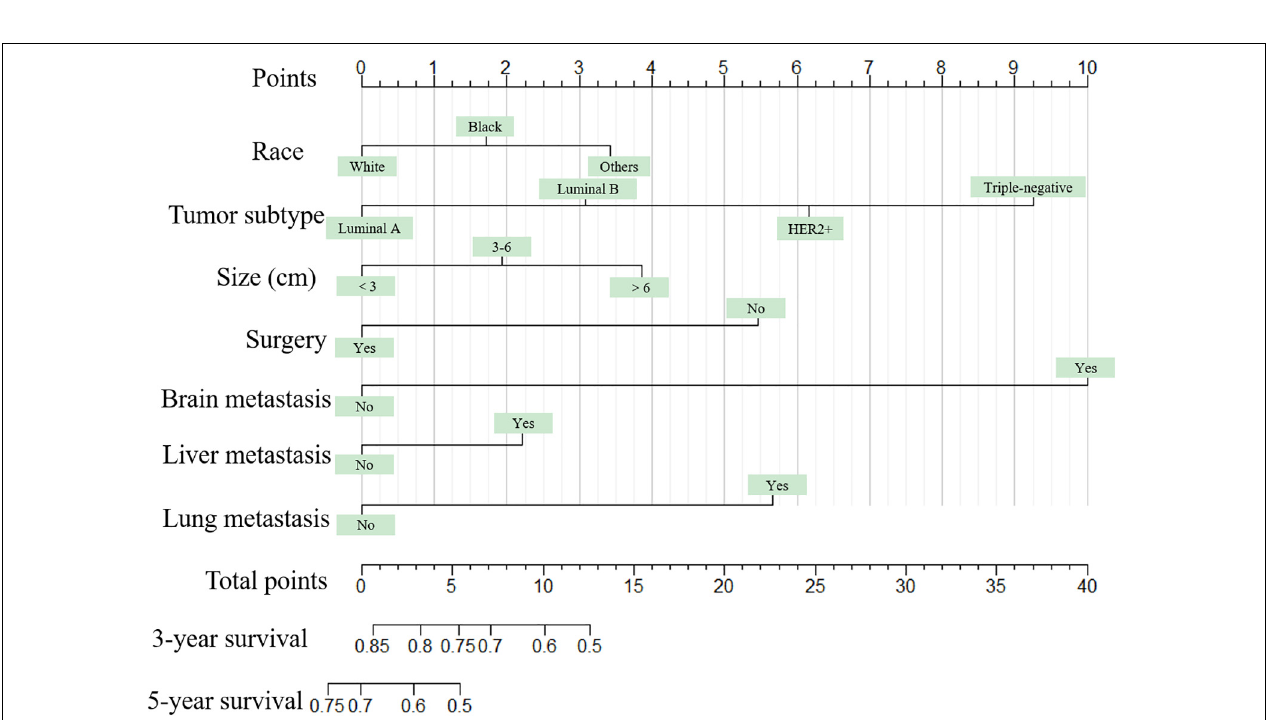
FIGURE 1 | The graph shows the nomogram predicting 3- and 5-year overall survival of young women with breast cancer bone metastasis. The nomogram summed the points identified on the scale for each predictor. The total points projected on the bottom scales indicate the probabilities of 3- and 5-year overall survival.